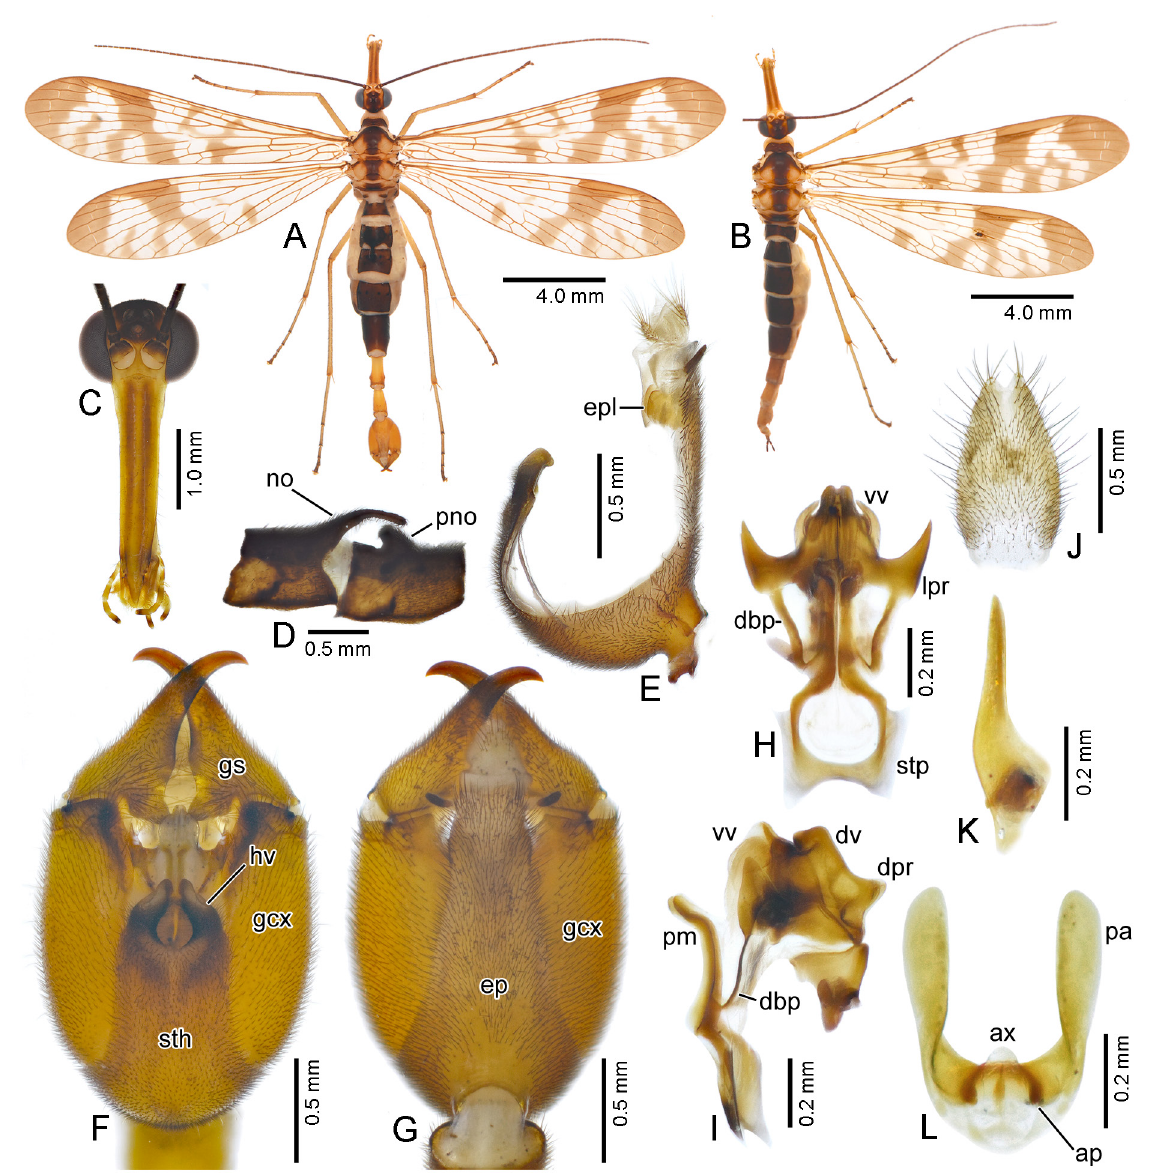
Fig. 6. Neopanorpa lungtaushana Cheng, 1957. A , C ‒ I . Male. A . Habitus, dorsal view. C . Head, frontal view. D . T3 and T4, left-lateral view. E . Epandrium and hypandrium, right-lateral view. F – G . Genital bulb, ventral and dorsal views, respectively. H – I . Aedeagal complex, ventral and right- lateral views, respectively. – B , J ‒ L . Female. B . Habitus, dorsal view. J . Subgenital plate, ventral view. K – L . Medigynium, right-lateral and ventral views,